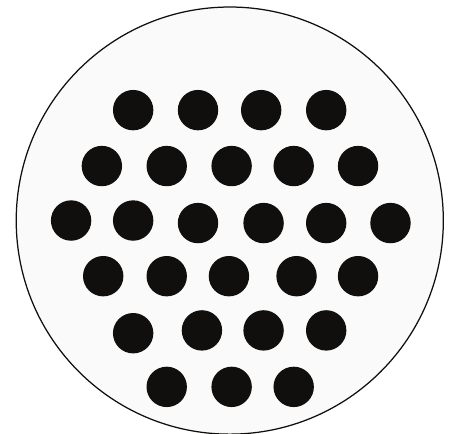
Figure 6: Schematic layout of the battery pack.